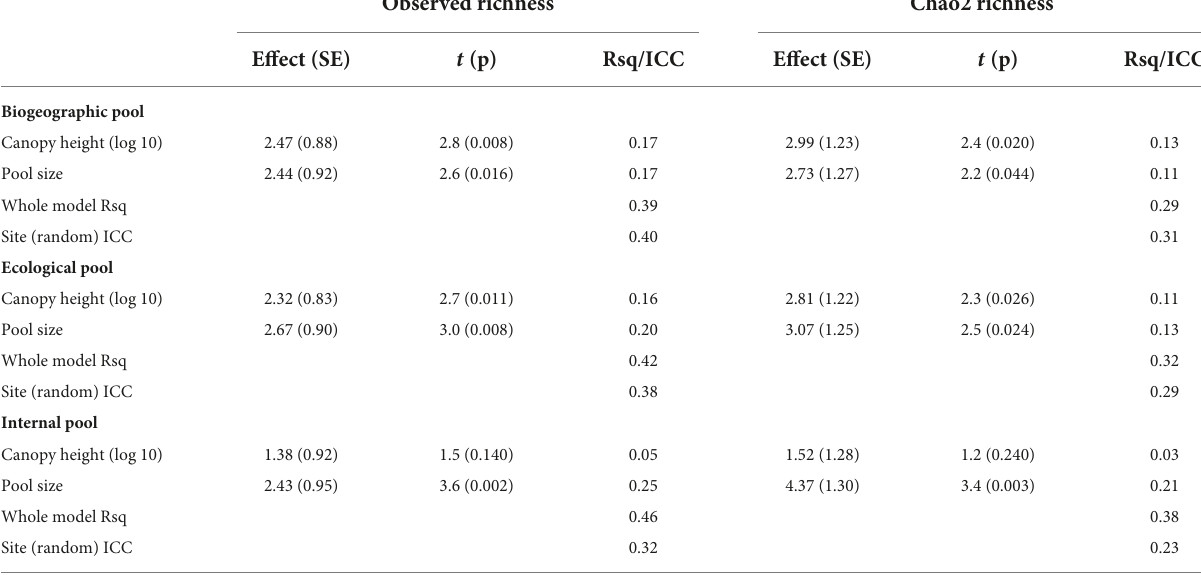
TABLE 1 Results of linear mixed models relating local species richness to canopy height and the size of the regional species pool. Observed richness Chao2